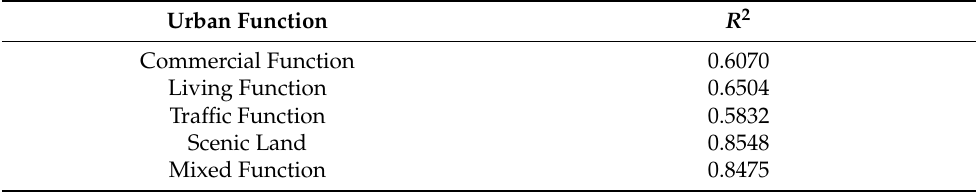
Table 6. R 2 values on different urban